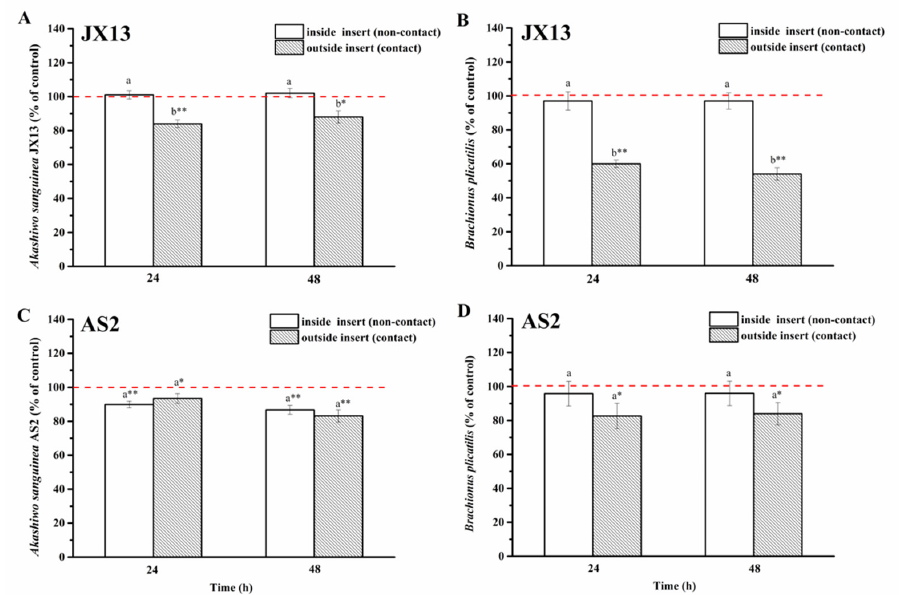
Figure 8. Half-contact coculture of Akashiwo sanguinea (JX13, AS2) and Brachionus plicatilis . ( A , B ): A. sanguinea JX13 co-cultured with B. plicatilis ; ( C , D ): A. sanguinea AS2 co-cultured with B. plicatilis . Initial cell density of A. sanguinea was 8000 cells mL − 1 , and the initial number of B. plicatilis was 8 for each well. Results are expressed in triplicate ± standard deviation (SD). Different lower-case letters (a,b) indicate significant differences ( p < 0.05) between treatments at the same co-culture times; * and ** indicate significant differences ( p < 0.05 and p < 0.01, respectively) between treatment and control.